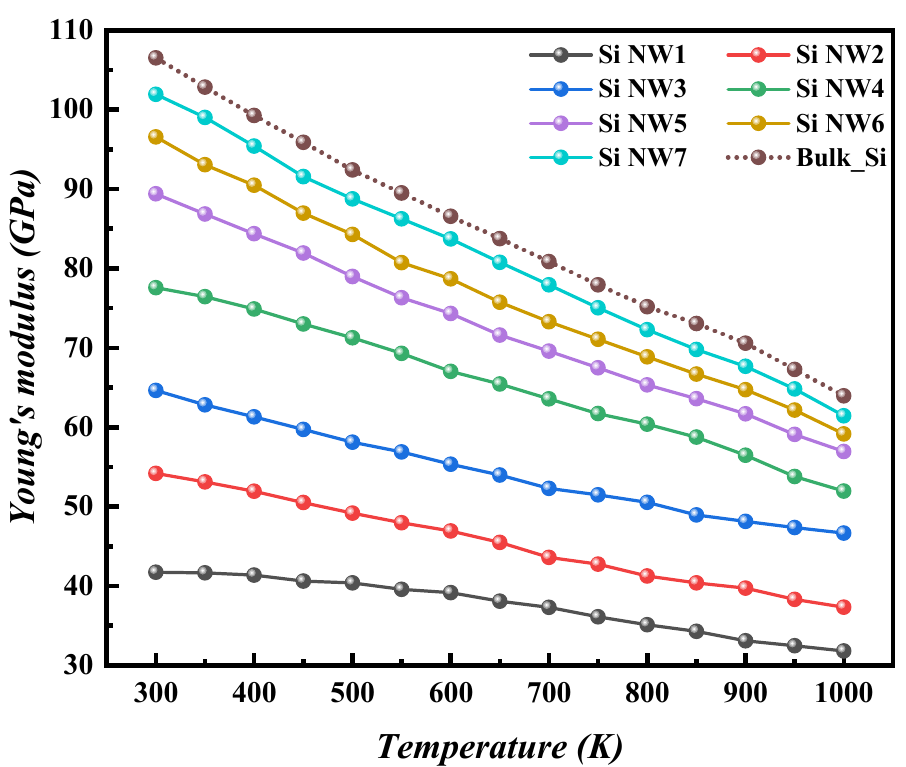
Figure 9. Young’s modulus of Si NWs with different diameters and bulk Si varying from 300 K to 1000 K.